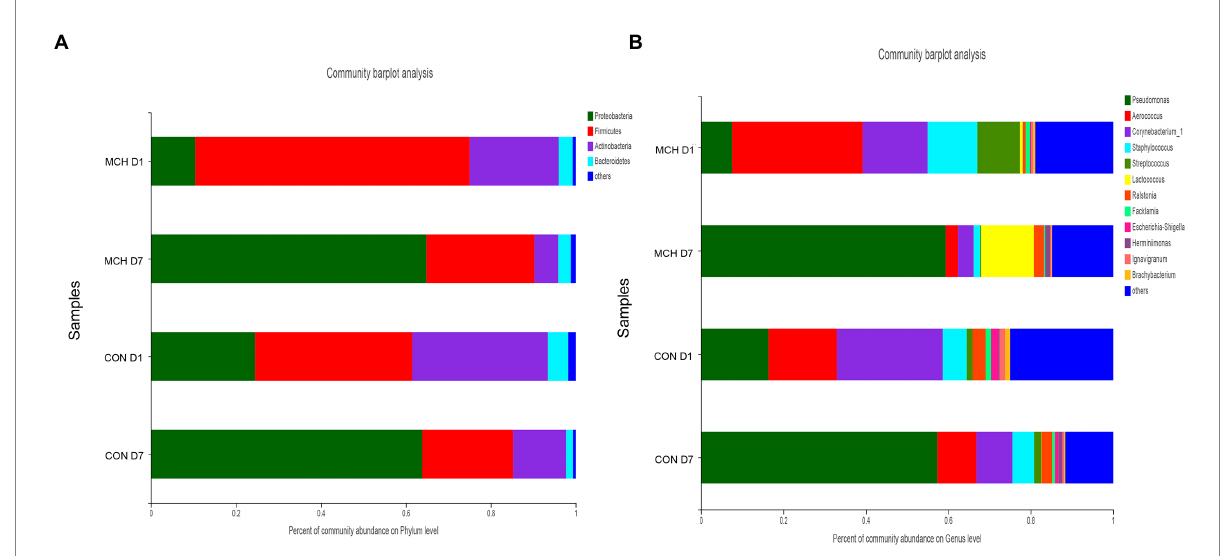
FIGURE 2 Classification of the bacterial community composition in milk samples on day 1 and day 7 between MCH group and CON group, n = 6. (A) Phylum level. (B) Genus’s level.